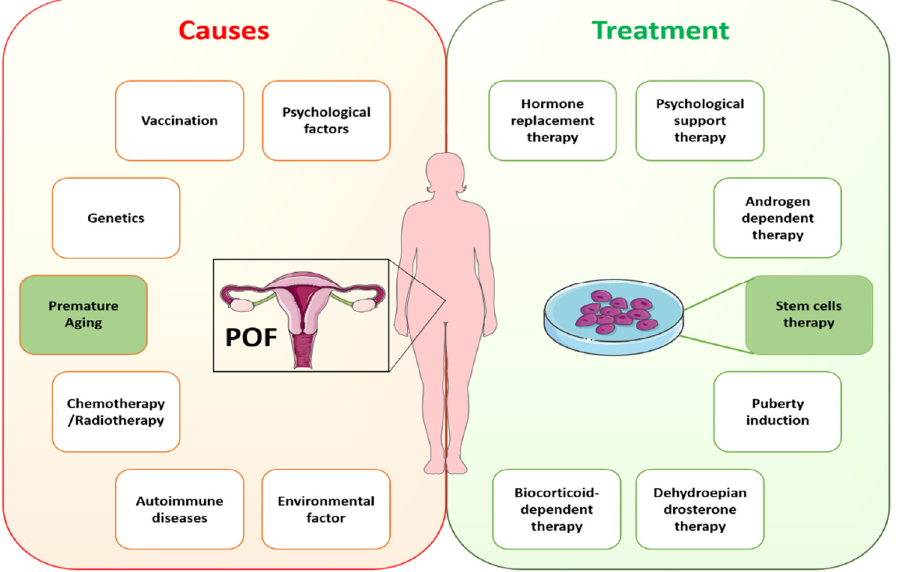
Figure 2. Probable causes of and treatment options for POI.